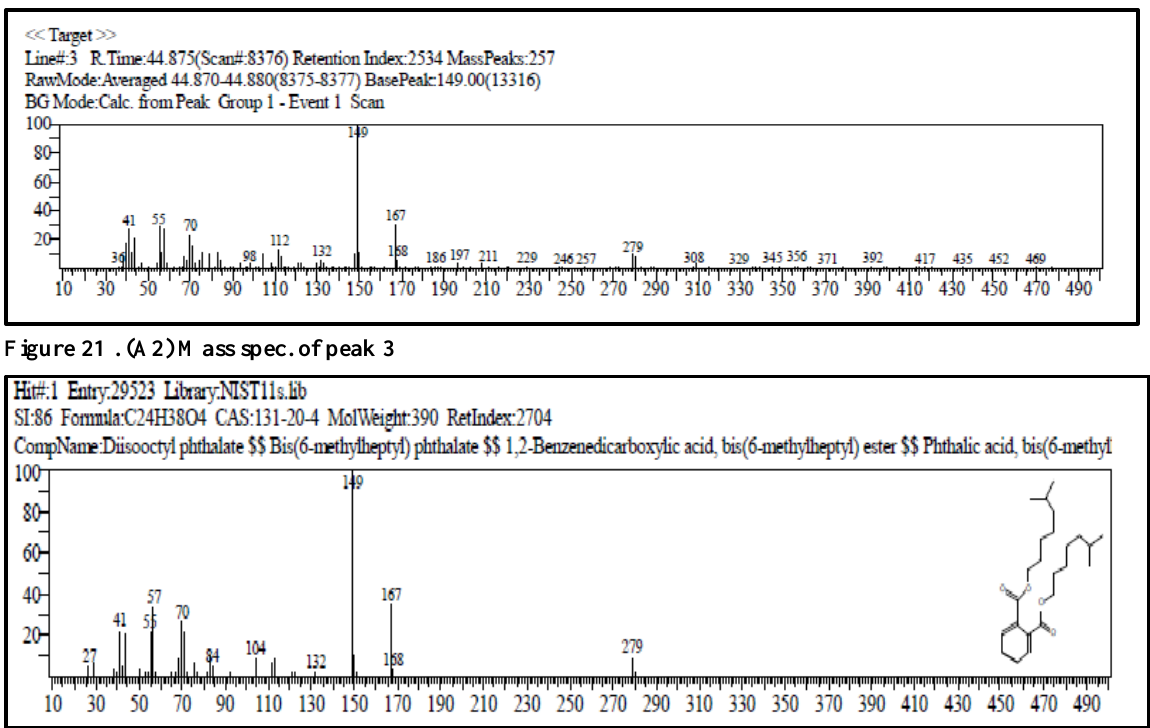
Figure21 . (B2) Mass spec. of Diisooctyl phthalate from NIST library From mass spec. of the figure 21 complete match of mass data between A2 and B2 indicate that peak 3 is Diisooctyl phthalate.